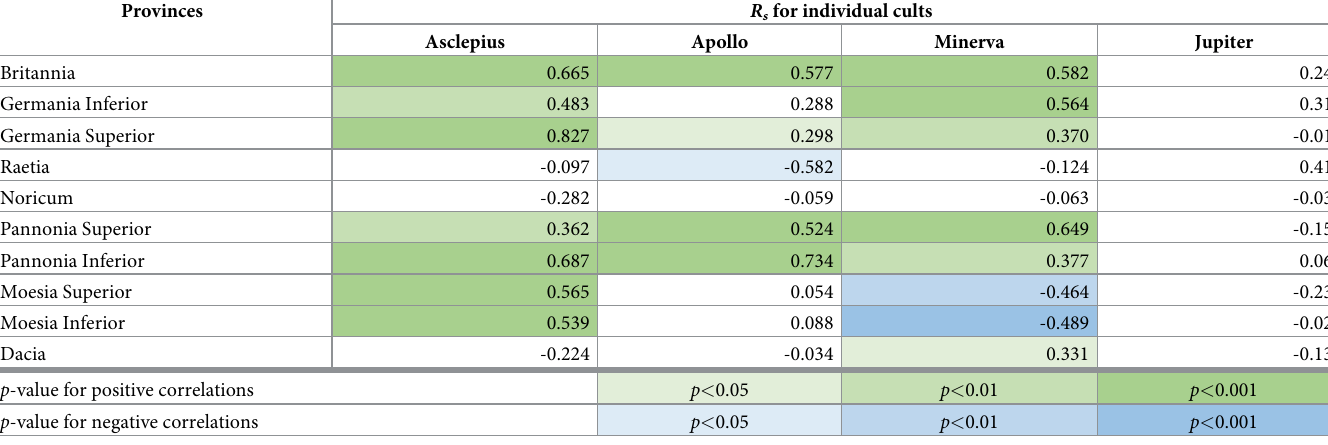
Table 3. Spearman correlation ( R s ) between distances from positions of Roman soldiers to their nearest proxy for the presence of a Roman physician and their near- est cult inscription in the era of the Roman Empire.